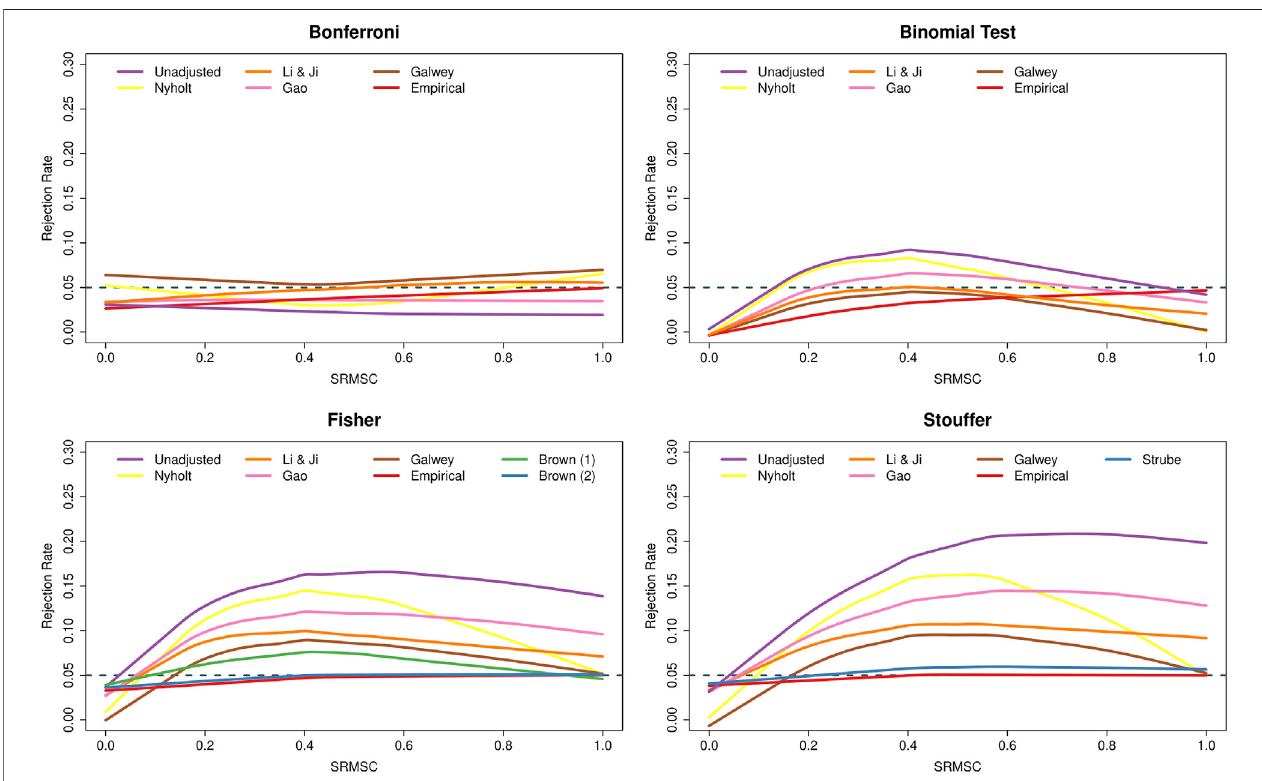
FIGURE 3 | Type I error rates of methods for gene-based testing as a function of the square-root mean squared correlation (SRMSC). The horizontal grey dashed line corresponds to the nominal rejection rate of α = 0.05. Brown (1) and Brown (2) refer to the one- and two-sided versions of Brown ’ s method (i.e., Eqs 13 , 14 ,